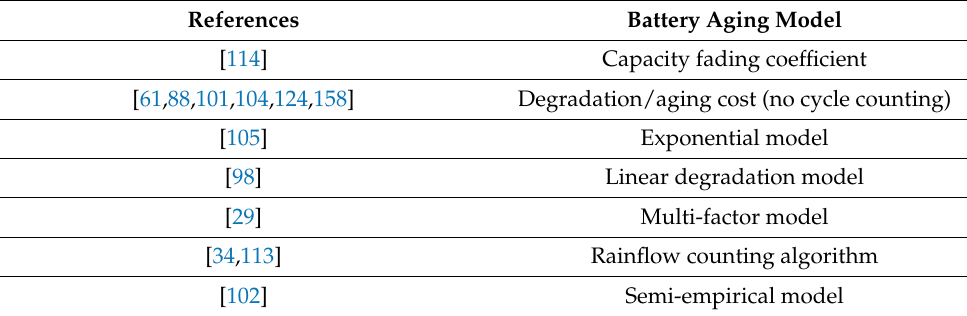
Table 12. Battery degradation models employed in the